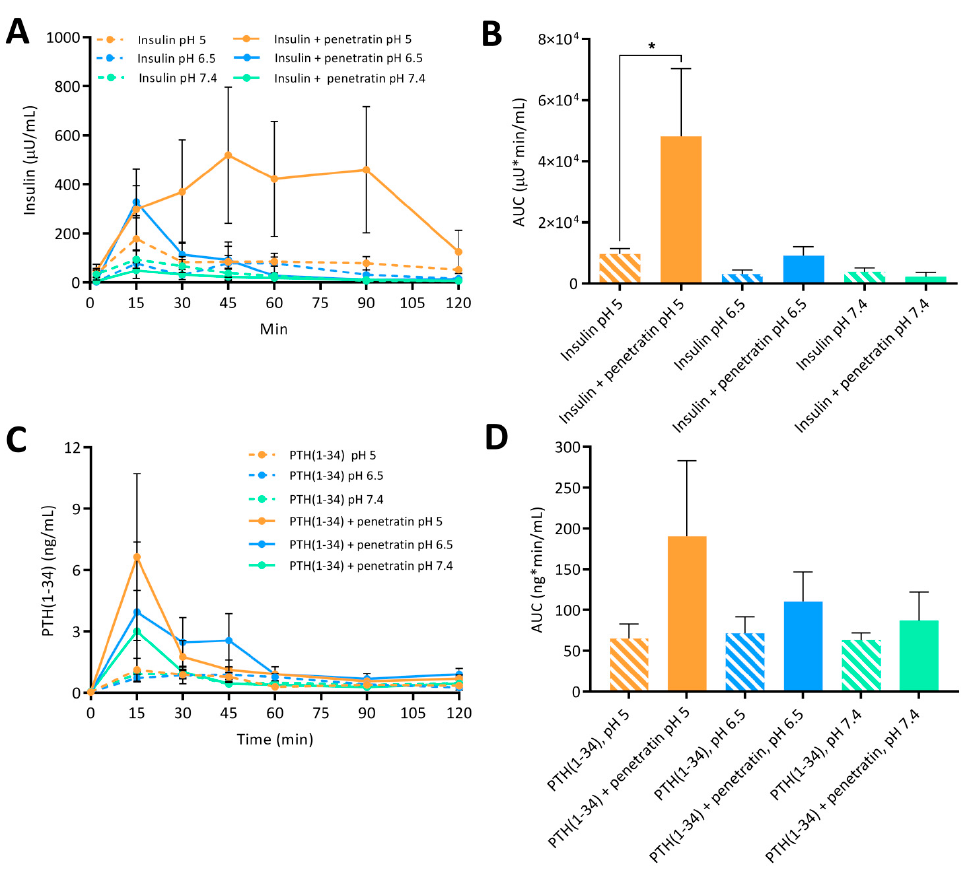
Figure 6. Plasma insulin ( A ) with associated AUC ( B ) and plasma PTH(1 ‐ 34) ( C ) with associated AUC ( D ) following intraintestinal administration of insulin (50 IU/kg) or PTH(1 ‐ 34) (1.2 mg/kg) alone or in